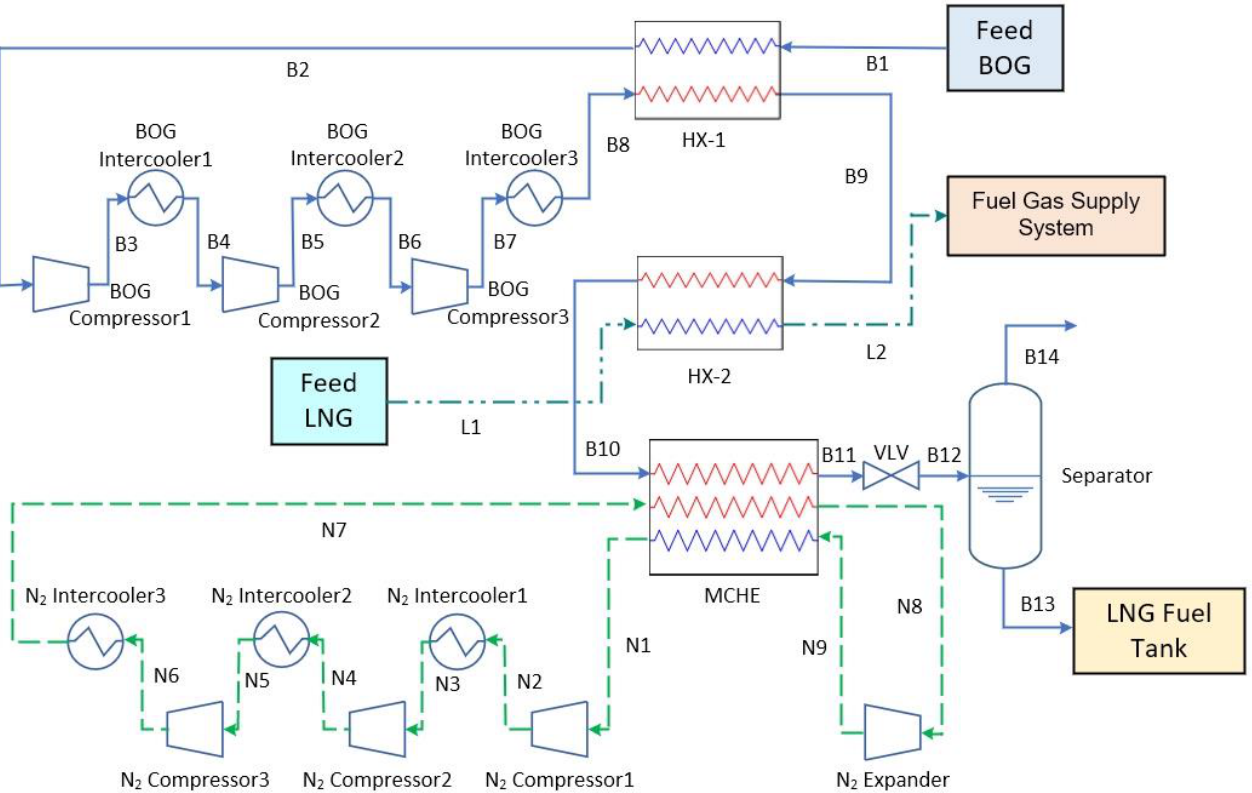
Figure 7. Schematic of the BOG re-liquefaction system for Case 1.